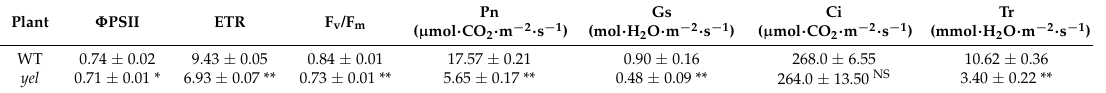
Table 1. Chl fluorescence and photosynthetic parameters of WT and yel